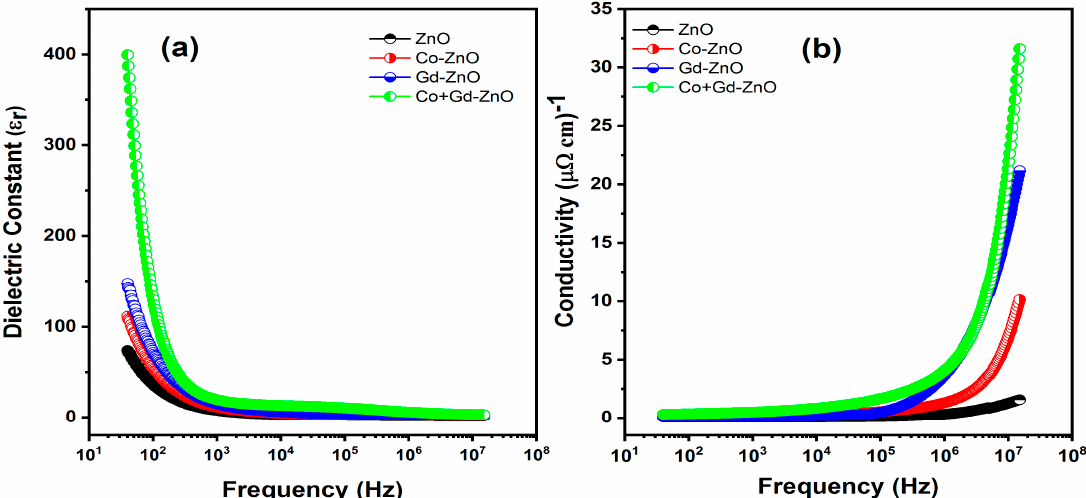
Figure 7. ( a )Dielectric constant and( b ) AC electrical conductivity for pure, Co-doped, and Co/Gd Figure 7. ( a ) Dielectric constant and ( b ) AC electrical conductivity for pure, Co-doped, and Co/Gd di-doped ZnO as a function of frequency. di-doped ZnO as a function of